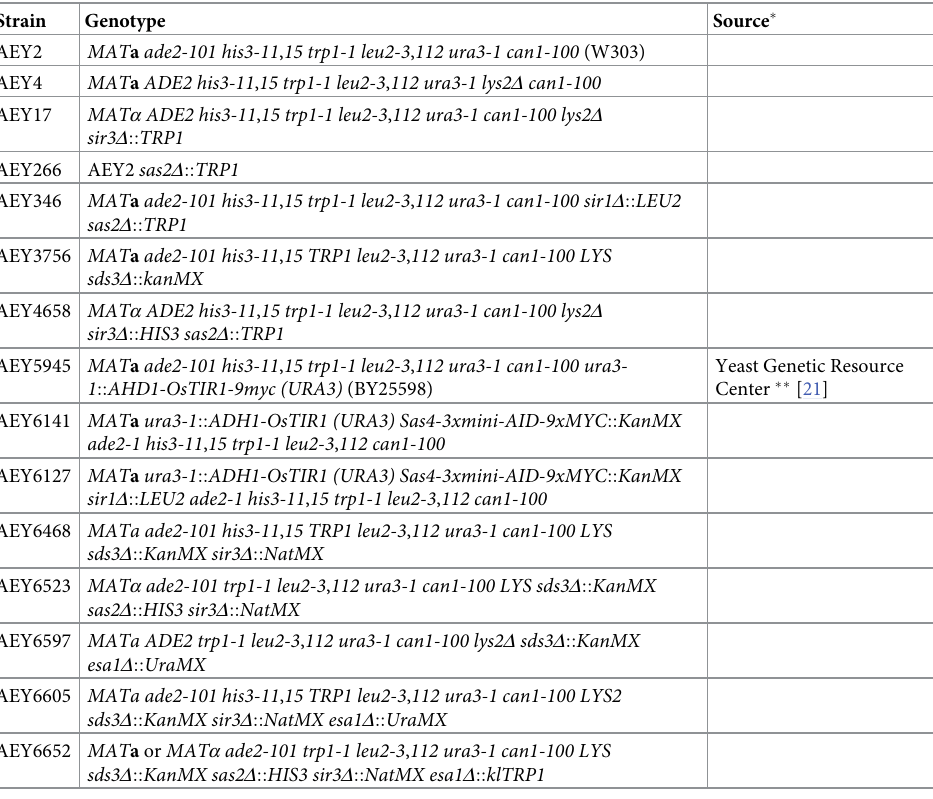
Table 1. S . cerevisiae strains used in this